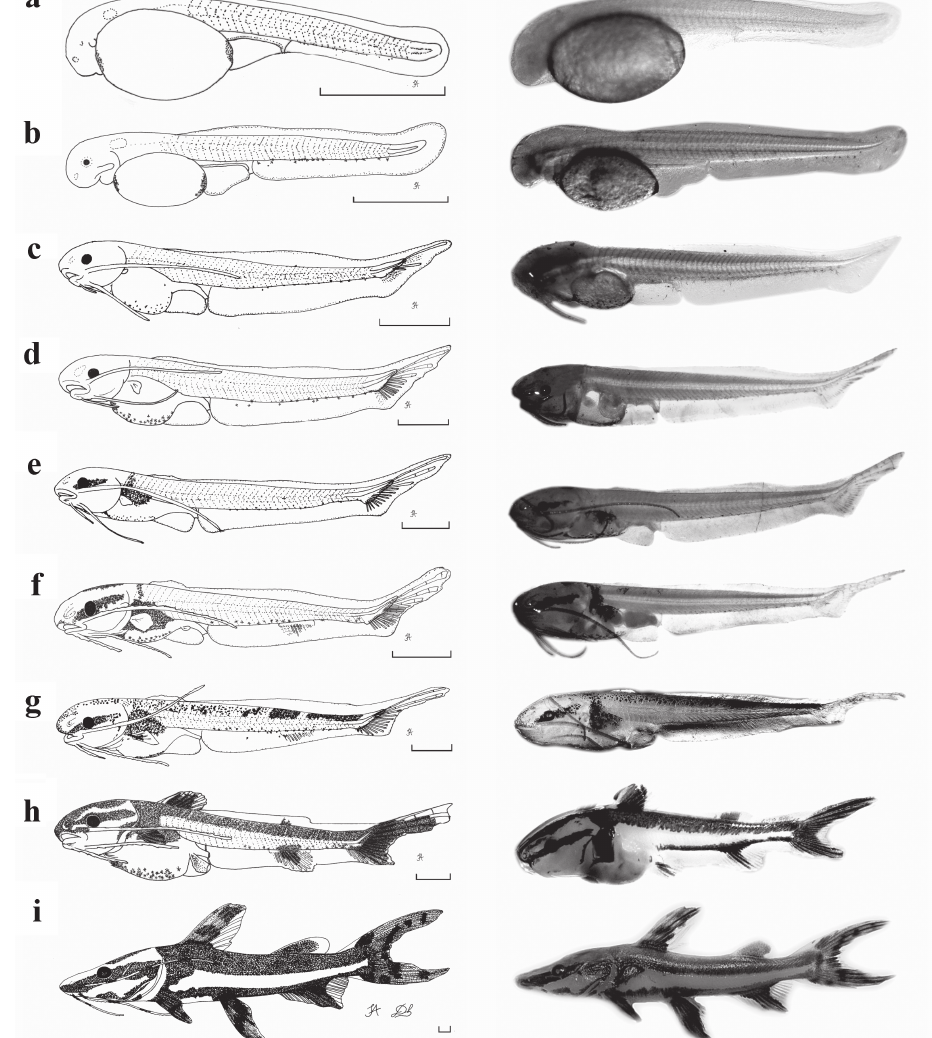
Fig. 4. Drawings and photographs of larvae at different stages and juvenile of Pseudoplatystoma reticulatum : (a) yolk-sac larva (newly-hatched): TL = 3.05 mm; (b) preflexion: age = 12 h, TL = 3.91 mm; (c) early flexion: age = 2 days, TL = 5.85mm; (d) intermediate flexion: age = 4 days, TL = 7.91mm; (e) late flexion: age = 6 days, TL = 8.22 mm; (f) early postflexion: age = 7 days, TL = 9.23 mm; (g) intermediate postflexion: age = 8 days, TL = 10.38 mm; (h) late postflexion: age = 10 days, TL = 9.55mm; and (i) juvenile: age = 21 days, TL = 36.42 mm. Scale = 1 mm.